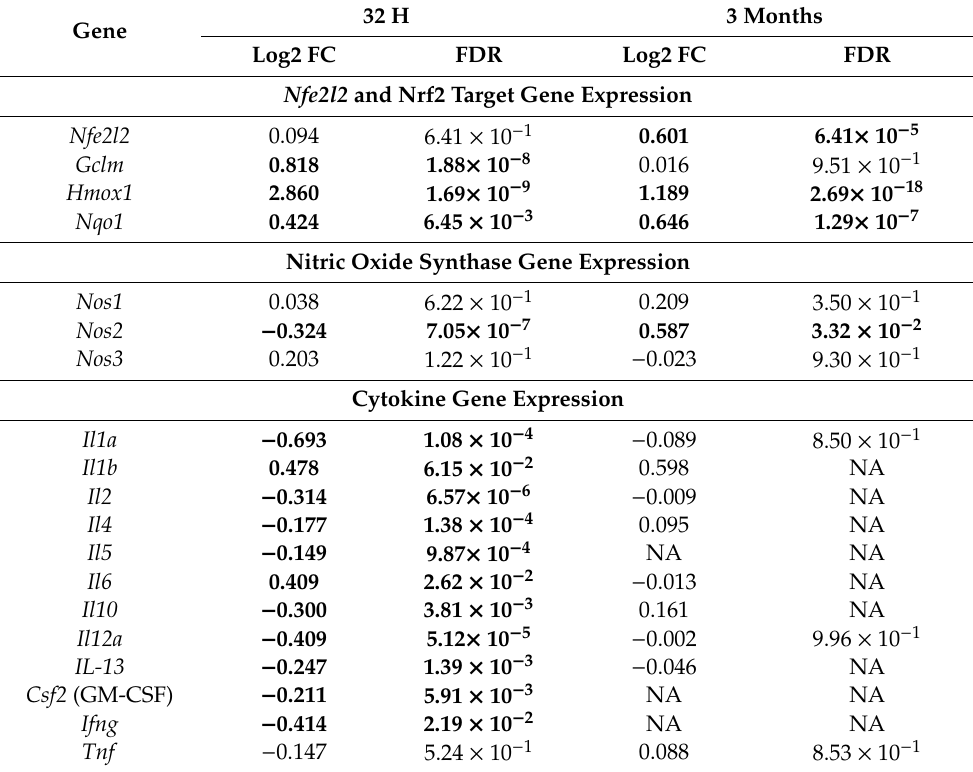
Table 2. Gene expression of Nfe2l2 and Nrf2 target genes, nitric oxide synthase and cytokine-encoding genes at 32 h and 3 months post-TBI in the rat perilesional